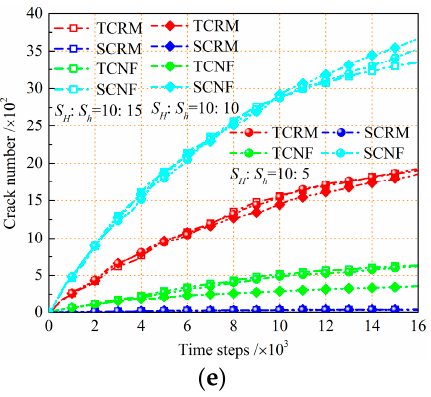
ρ ρ ρ ρ ρ ρ ρ ρ = 24/m; ( b ) = 36/m; ( c ) = 48/m; ( d ) = 60/m; = 24/m; ( b ) = 36/m; ( c ) = 48/m; ( d ) = 60/m;